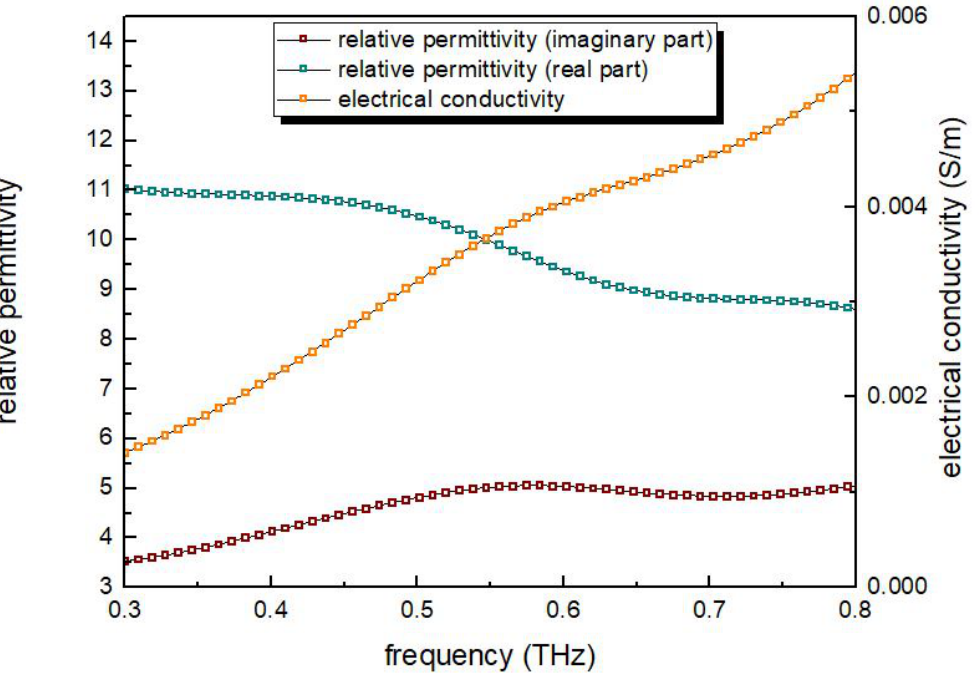
Figure 5. The properties of mica substrate used in the simulation in the frequency range of 0.3–0.8